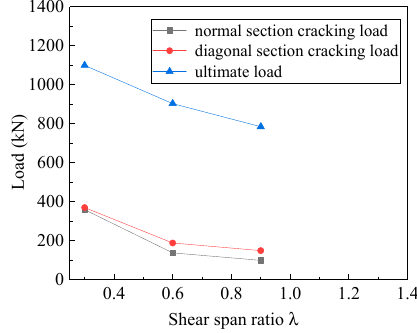
Figure 7. Relation curve between λ and load.